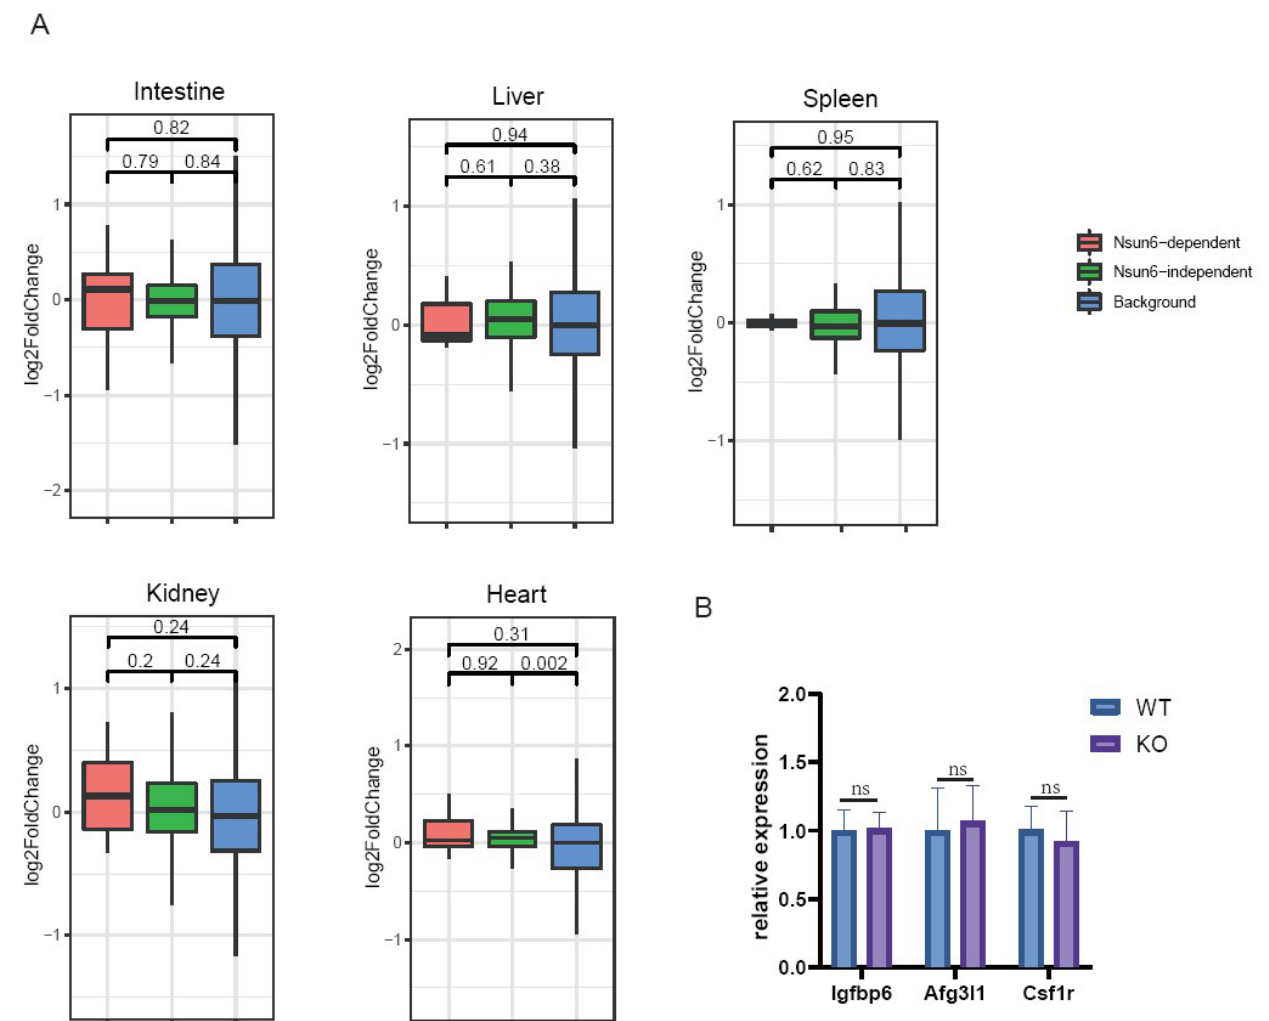
Figure 6. Box plots presenting the global mRNA level changes of Nsun6 target genes. ( A ) The red, green, and blue boxes represent the global mRNA level changes of genes with Nsun6-dependent and -independent m5C sites and of genes without m5C sites, respectively. ( B ) The mRNA levels of highly modified Nsun6 target genes Igfbp6, Afg3l1, and Csf1r were compared between WT and KO heart tissue using RT-qPCR.